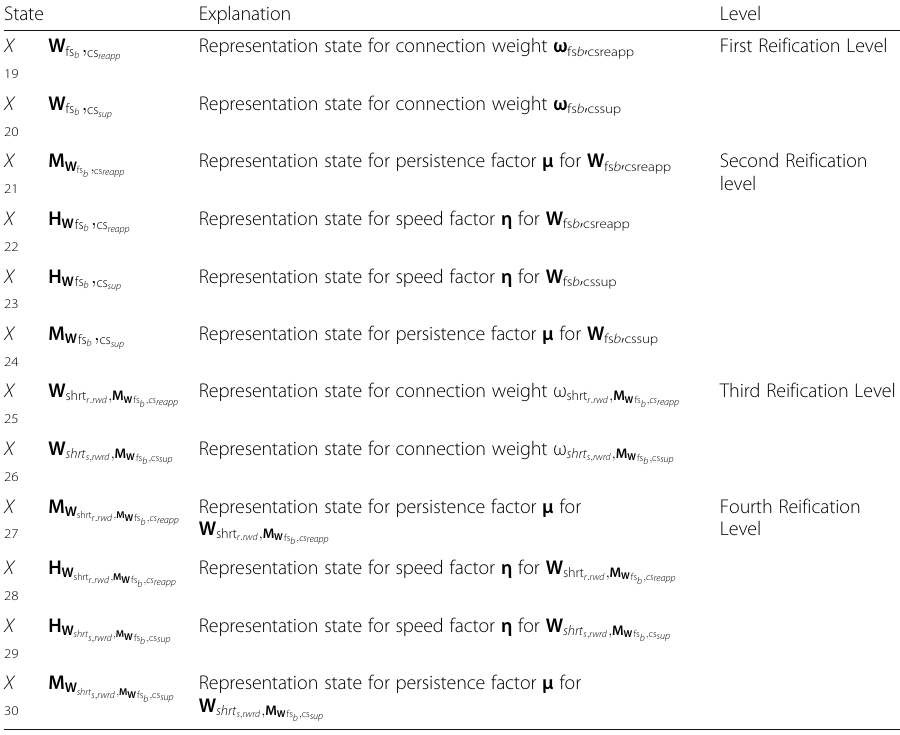
Table 2 Nomenclature of the states at the different adaptation